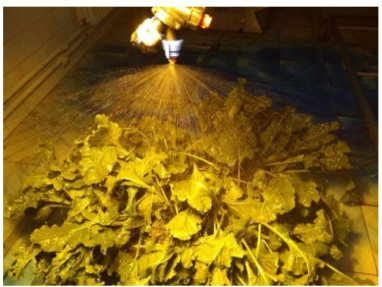
Figure 1. Treated sugar beet plants in laboratory